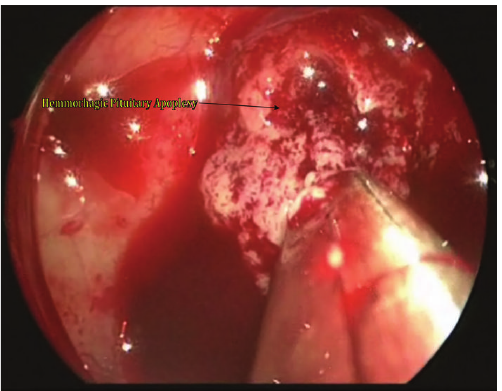
Figure 3: Intraoperative view through the operative endoscope revealing the hemorrhagic pituitary apoplexy being removed in a piece meal